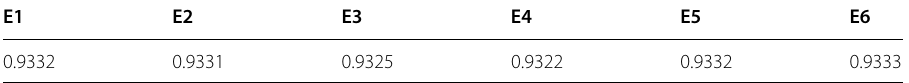
E1 is ensemble of K-CNN, RF and RGF; E2 is ensemble of K-CNN, RF and XGB; E3 is ensemble of K-CNN, RGF, XGB; E4 is ensemble of K-CNN, RGF and CatBoost; E5 is ensemble of K-CNN, RF, RGF and CatBoost; E6 is ensemble of K-CNN, RF, RGF and XGB; performance in terms of Normalized Gini Coefficient